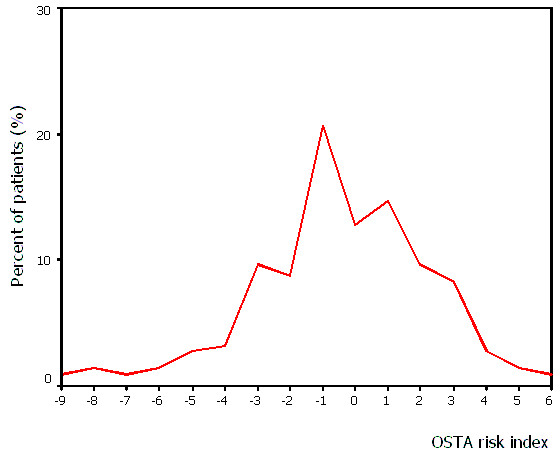
Distribution of the patients according to their OSTA risk index.